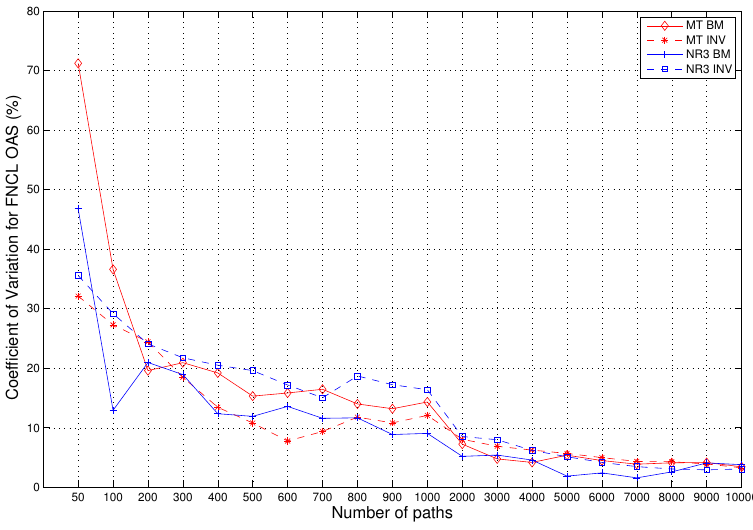
Figure 1. The convergence of OAS for the FNCL. The vertical axis is for the coefficient of variation (%). The horizontal axis is the number of